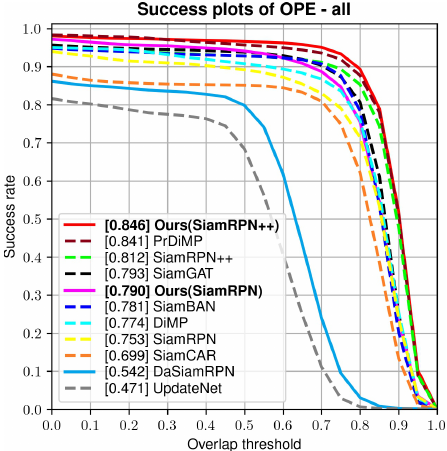
Figure 9. Overall success plot of the state-of-the-art